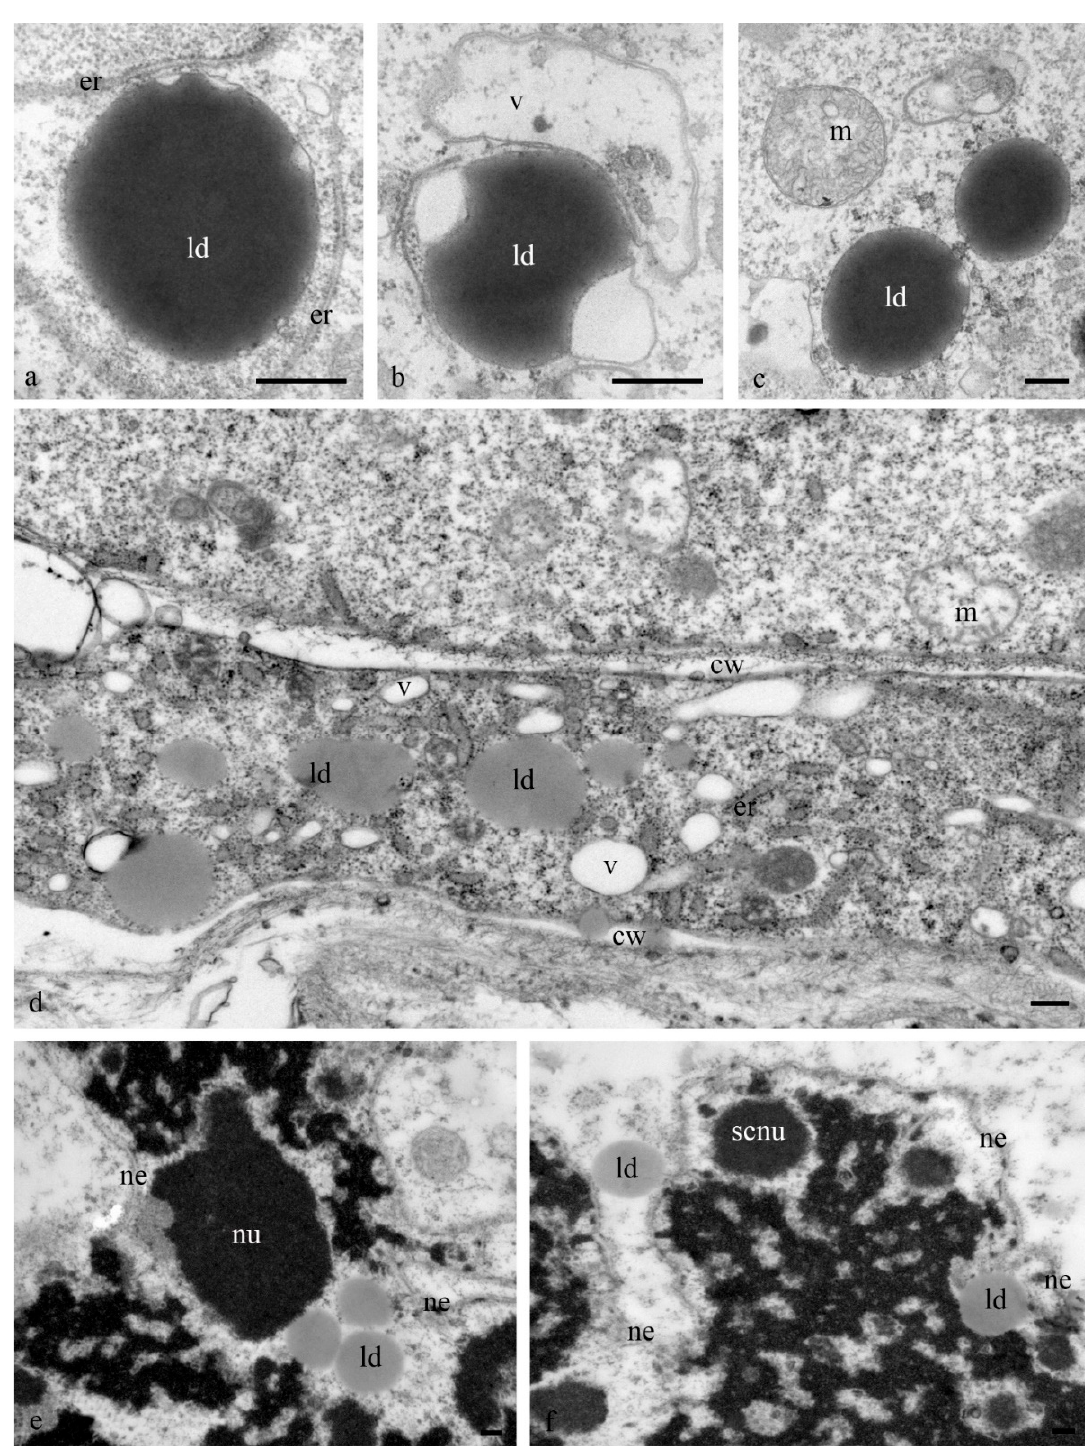
Figure 6. Ultrastructure of the lipid droplets of the antipodal wheat embryo sac cells at various stages of differentiation and programmed cell death. Lipid droplets (ld) in the cytoplasm at the early stage of differentiation ( a – d ) and in the nuclei during PCD ( e, f ). ld—lipid droplets; cw—cell wall; ne—nuclear envelope; nu—nucleolus; v—vacuoles; m—mitochondria; chr—polytene chromosomes; scnu—segregated components of the nucleolus; er—granular reticulum. The scale is 2 µm.